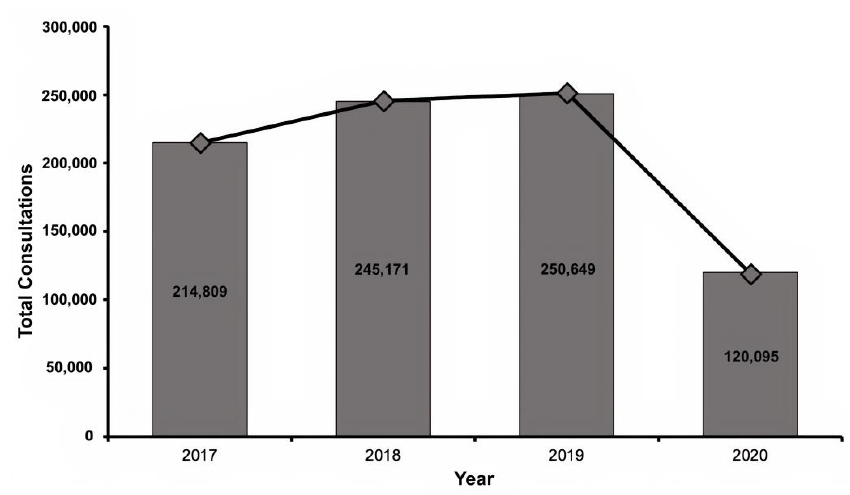
Figure 1. Total dermatology consultations in the public health sector from 2017 to 2020.